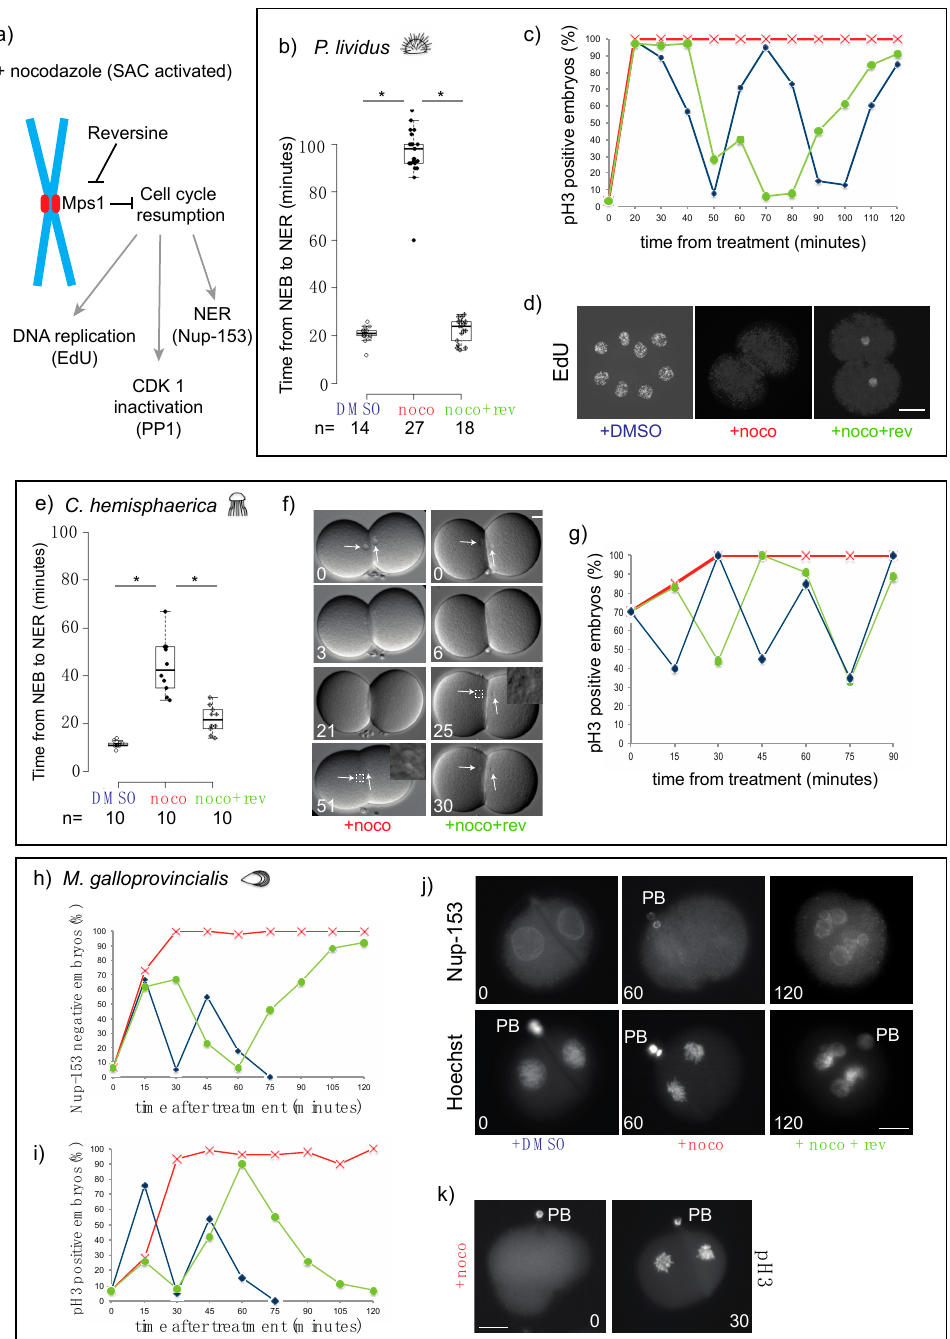
Figure 2. Microtubule depolymerization causes an Mps1-mediated mitotic block in cleavage stage embryos of P. lividus , C. hemisphaerica , and M. galloprovincialis. ( a ) Schematic representation of the effect of reversine on cell cycle progression during spindle assembly checkpoint (SAC) activation (+ nocodazole). ( b ) Quantification of duration of mitosis in P. lividus embryos treated with DMSO, nocodazole, or nocodazole and reversine. Mitosis was measured as time from nuclear envelope breakdown (NEB) to nuclear envelope reformation (NER). Boxes represent 25th–75th percentiles and the median is shown; whiskers mark 5th and 95th percentiles. Each dot represents one cell. Asterisks